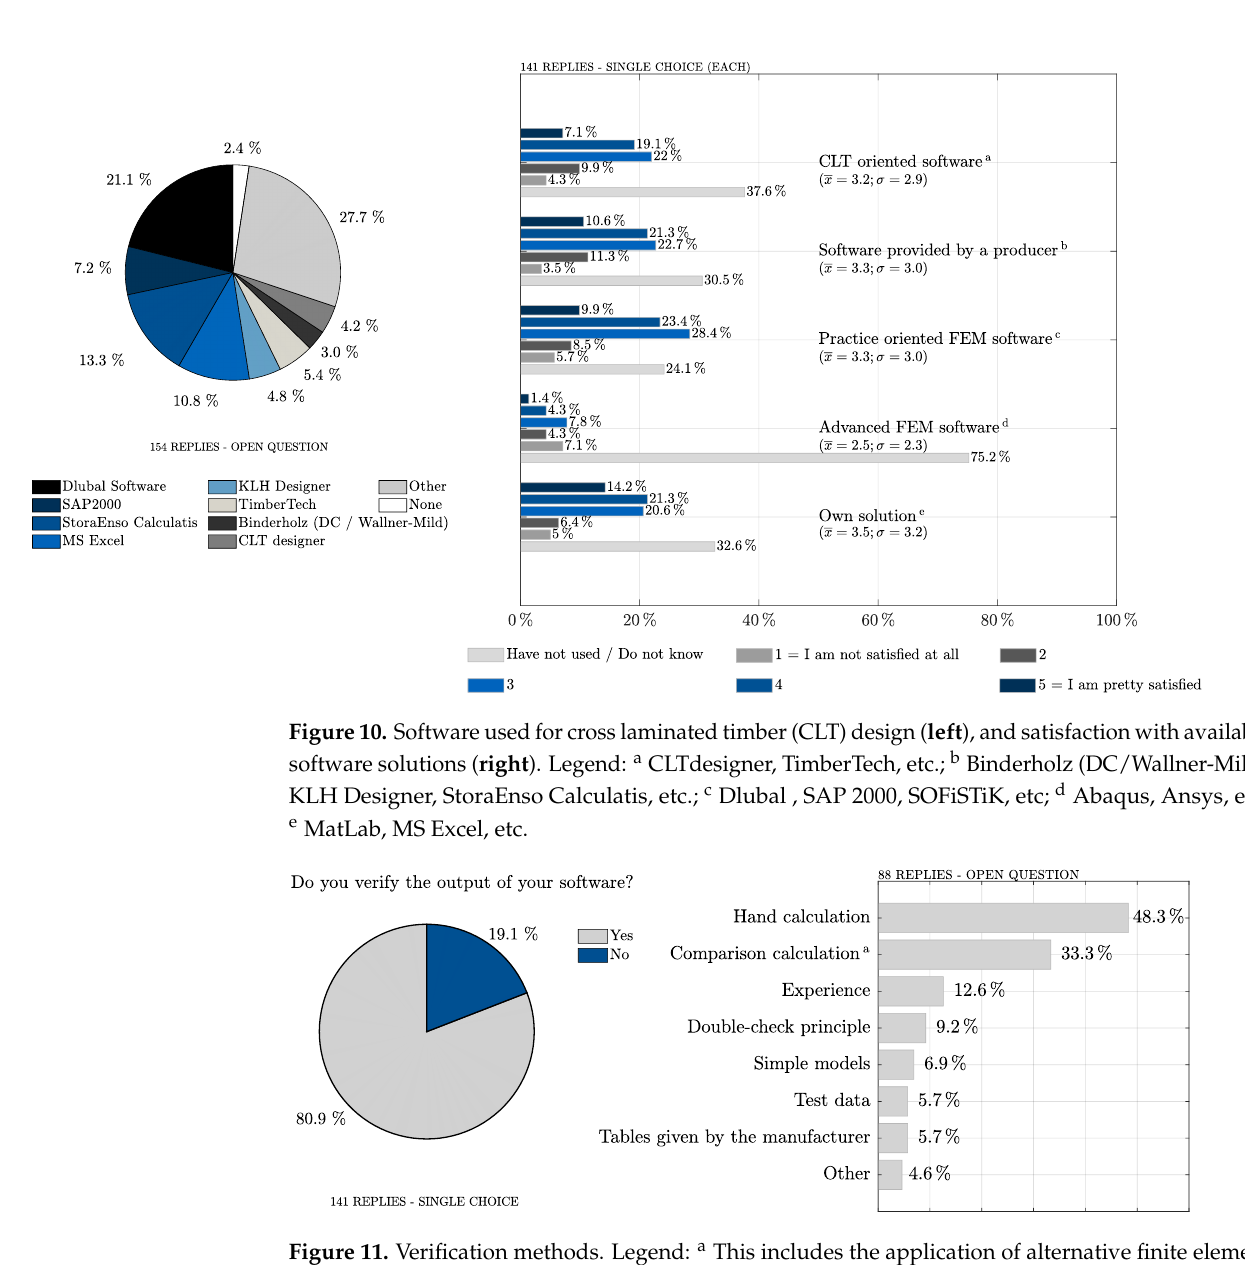
Figure 11. Verification methods. Legend: a This includes the application of alternative finite element software and own software solutions i.e., Matlab, MS Excel,